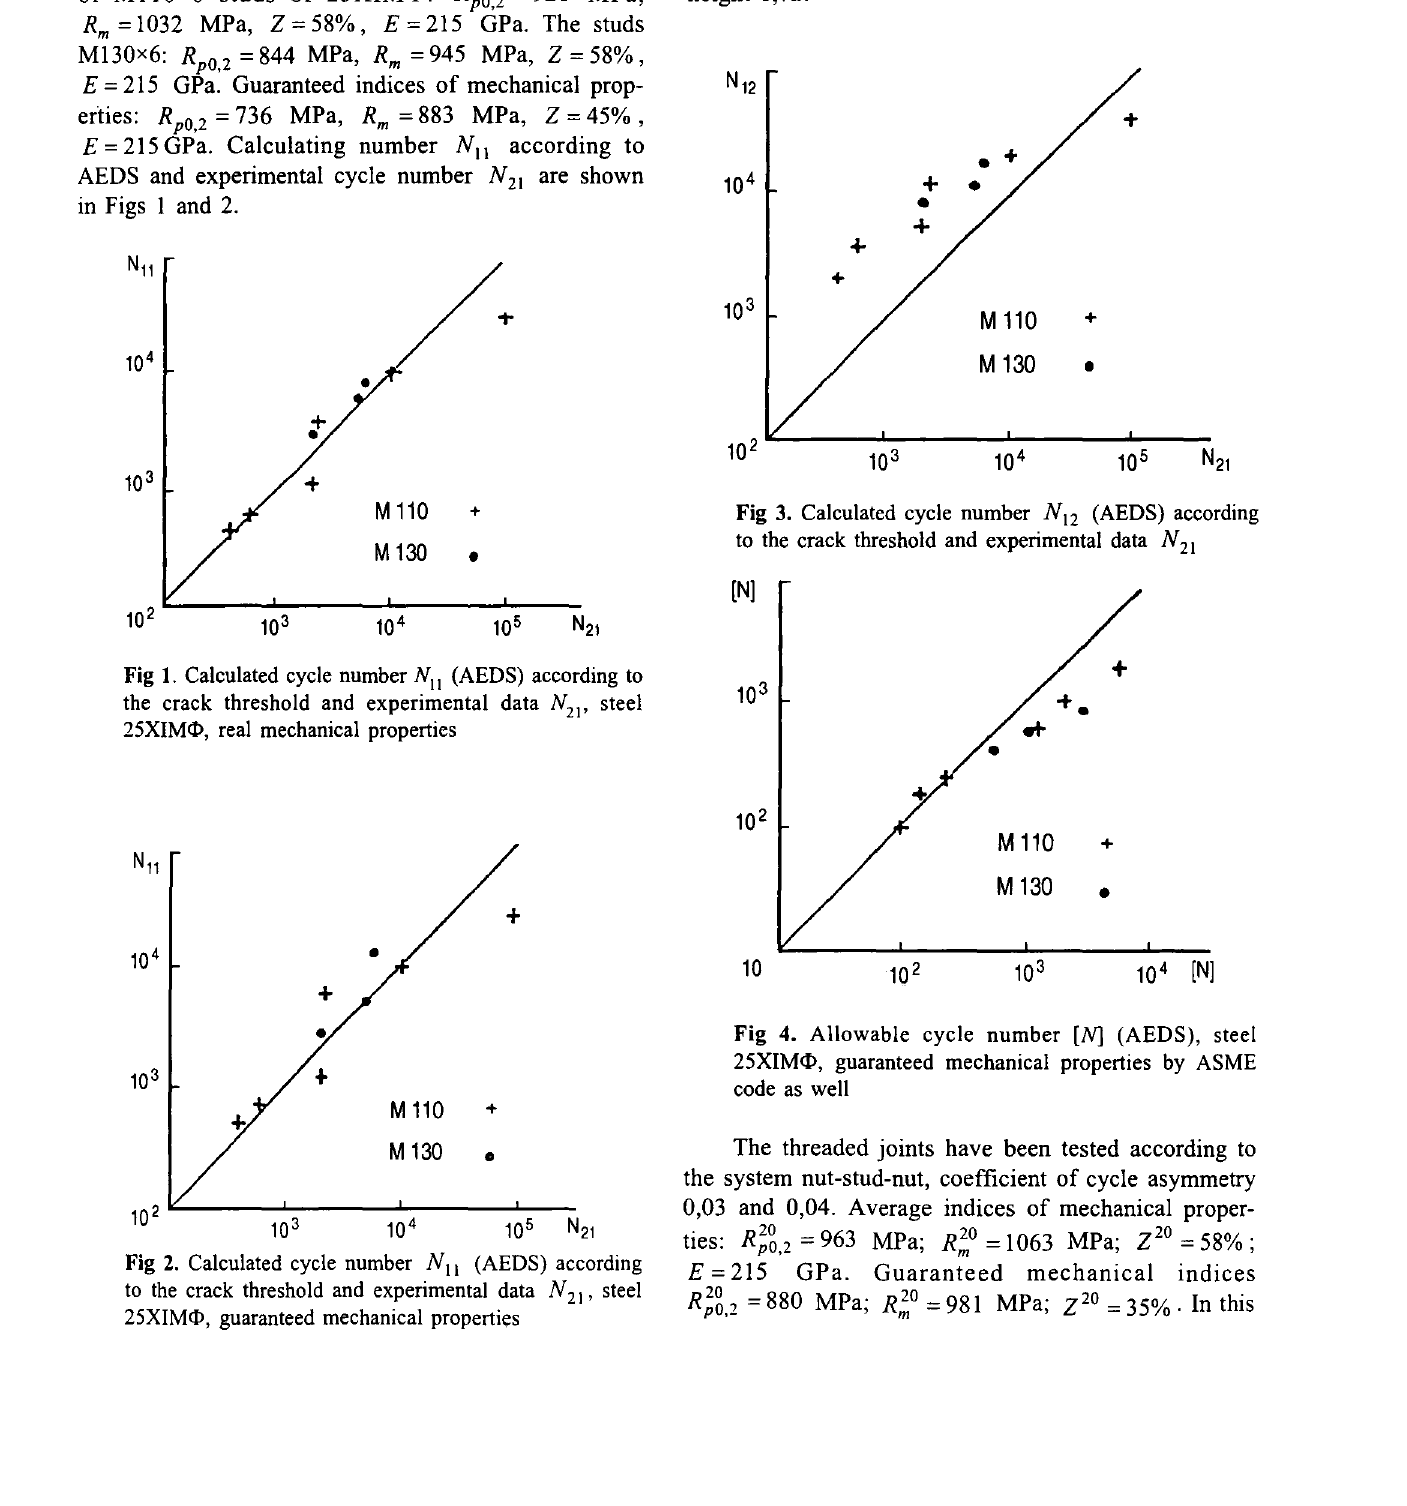
(AEDS) according 11 steel 21 ,